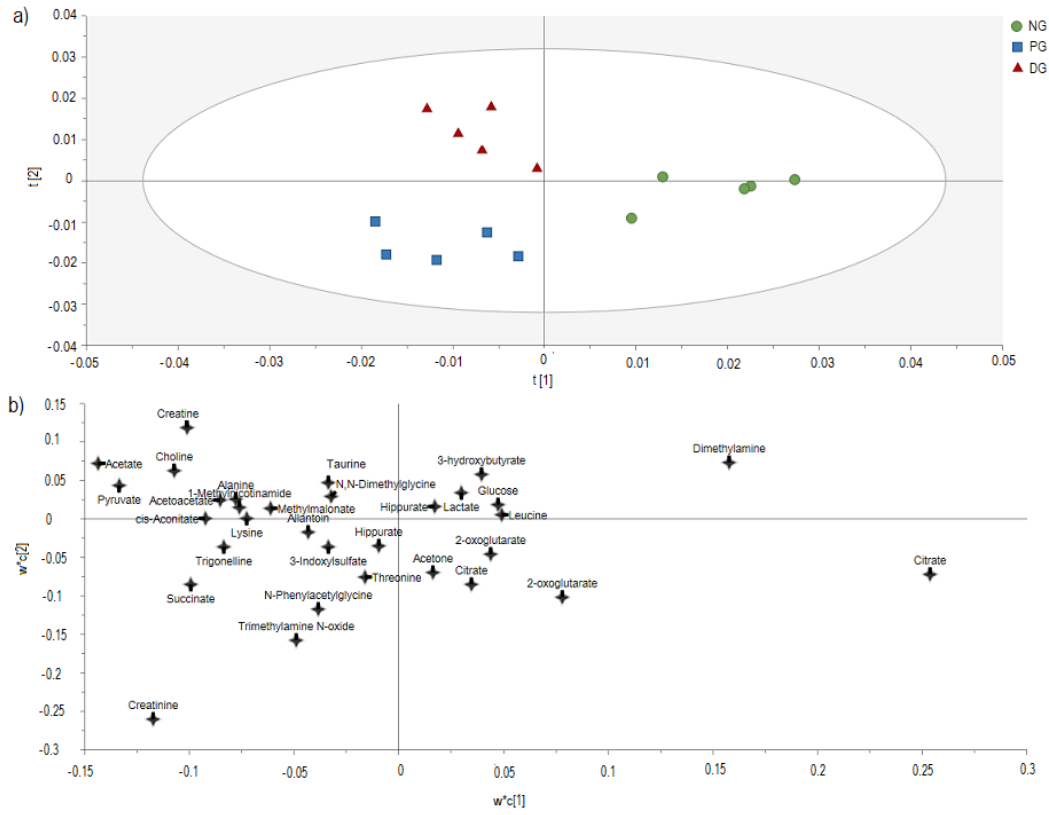
Figure 2. PLS-DA model. ( a ) Score plot ( b ) loading scatter plot obtained using 1 H-NMR spectra of urine samples in normal rats group (NG), hypercholesterolemic positive control group (PG) and hypercholesterolemic rats treated with 2% DDP group (DG) after 30 days of the treatment period (R 2 Y = 0.973, Q 2 = 0.834)